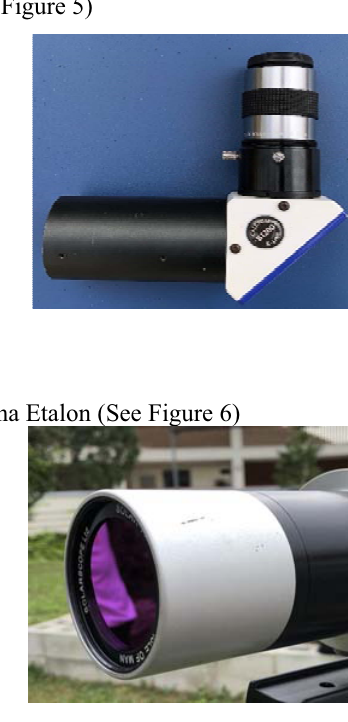
Figure 6. H-Alpha etalon ASI174MM Camera (See Figure 7)